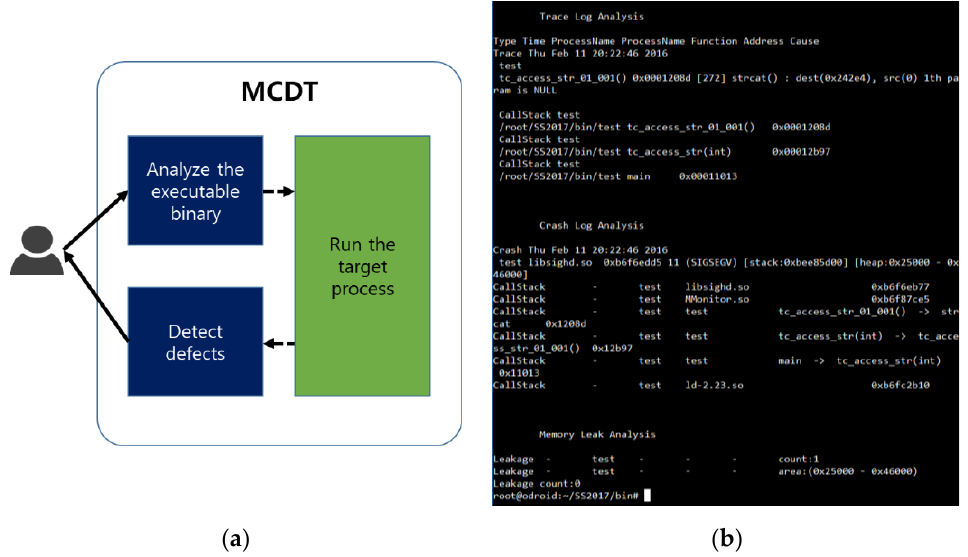
Figure 10. Use of the tool (memory corruption detection tool); ( a ) automation of defect-detection; ( b ) tool execution window.